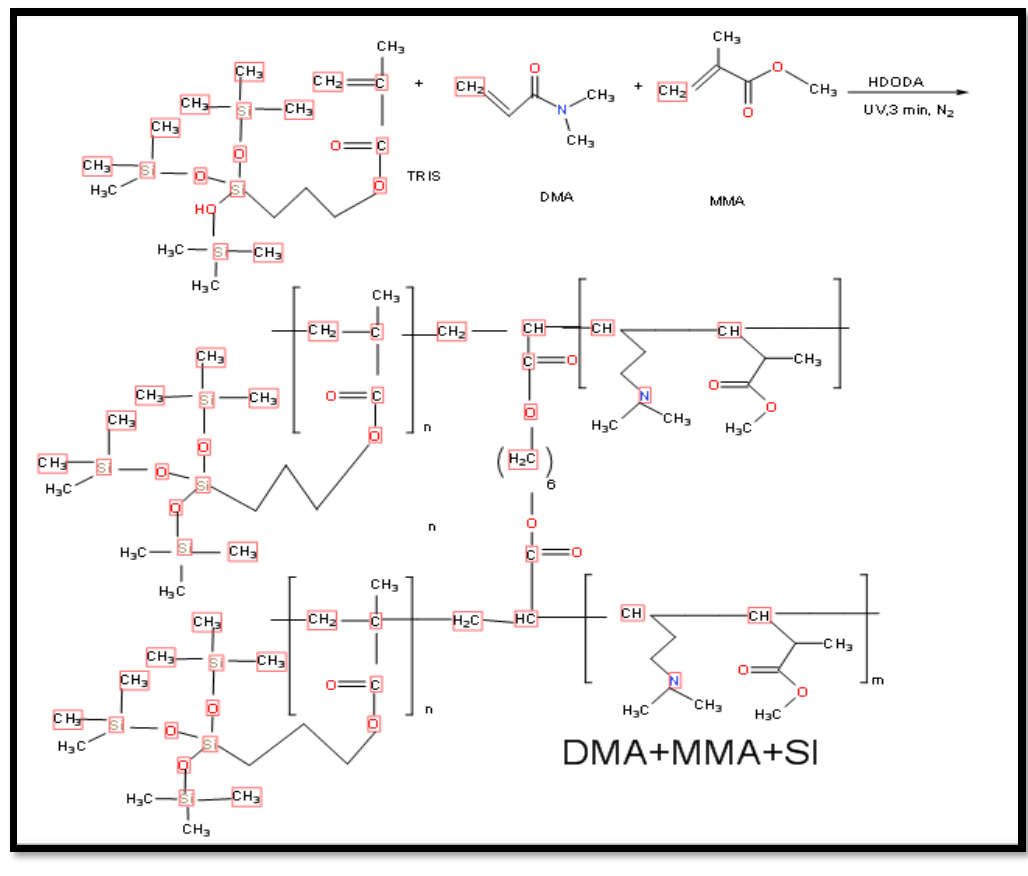
Fig. 5. Copolymerization and Crosslinking of HDODA with TRIS-co-